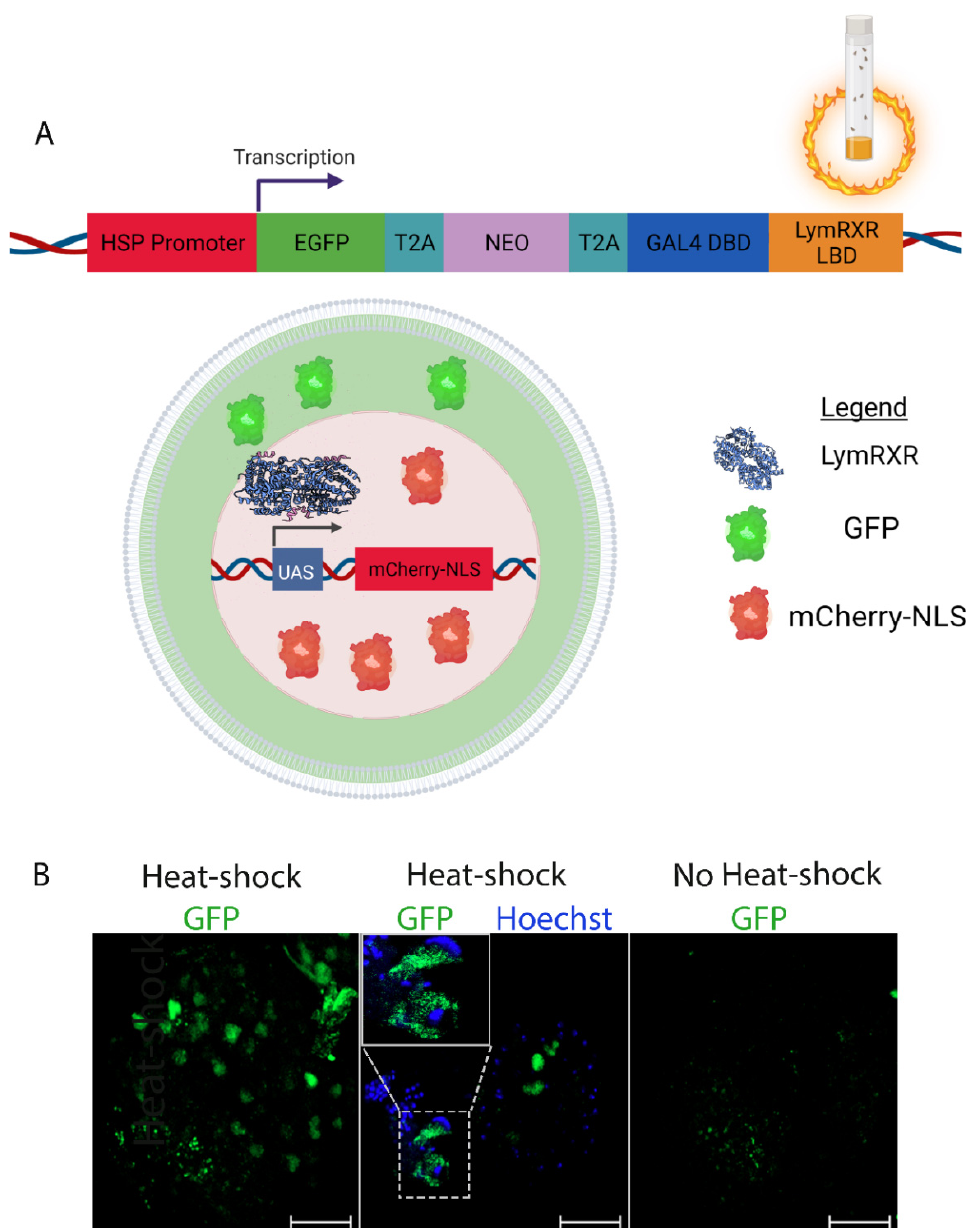
Figure 1. Ligand sensor design and expression. ( A ) Design of the ligand sensor system. Heat-shock of LymRXR ligand sensor flies results in cellular expression of GFP (primarily cytoplasmic localiza- tion) and the LymRXR ligand sensor (nuclear localization). Upon activation of LymRXR sensor while bound to UAS sequences, there is expression of nuclear localized mCherry (image made with Biorender). ( B ) Representative images of GFP expression in the CNS of LymRXR sensor larvae (fly line #2) following heat-shock (left and middle panels), compared to non-heat-shocked controls (right panel). The middle panel shows both GFP expression and Hoechst nuclear stain in a surface image of a CNS hemisphere. Inset shows enlarged image of cells showing clear cytoplasmic localization of GFP, with minimal overlap with Hoechst. Scale bars: 50 μ m.